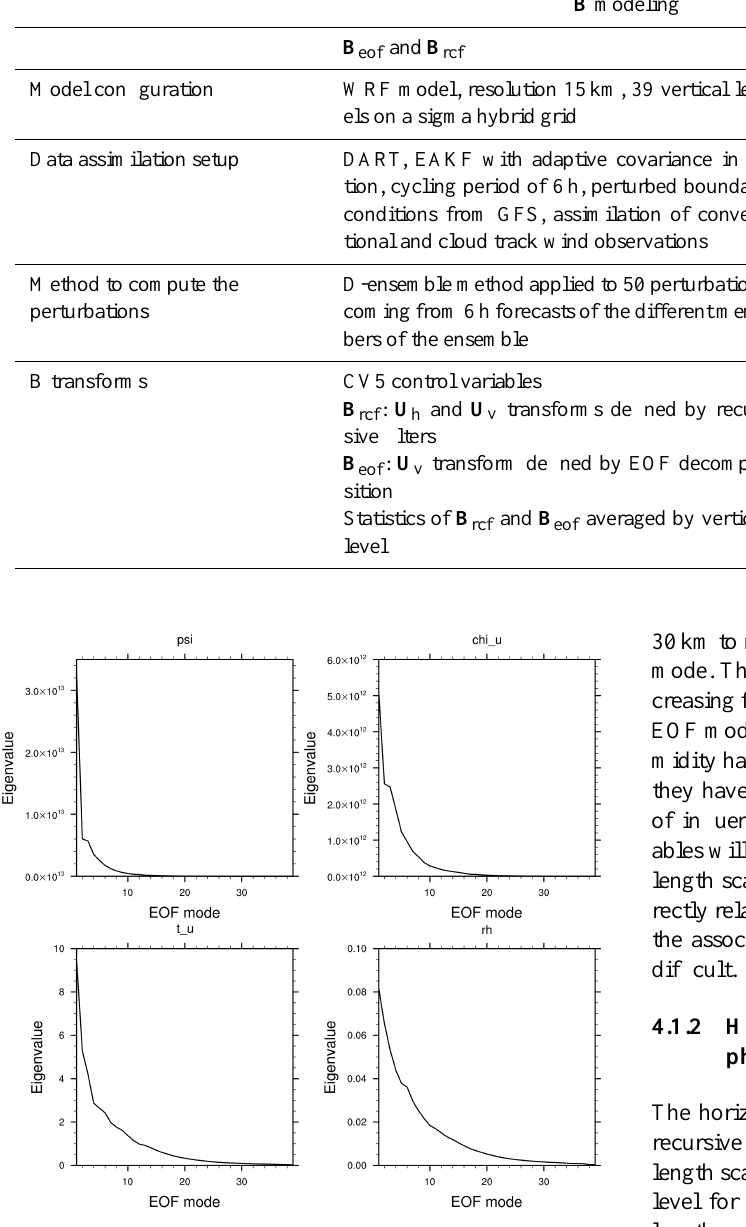
Figure 7. Eigenvalues computed by EOF mode for (a) psi, (b) chi u , (c) t u and (d) RH. They represent the variance of the control vari- ables (WRF, res. 15km, D-ensemble,